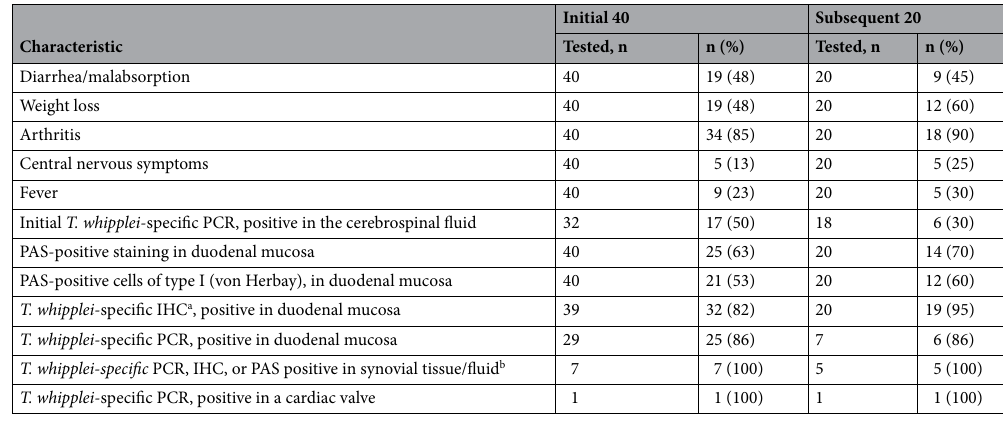
Table 1. Baseline clinical characteristics in the two groups of patients with Whipple’s disease. Significance (Fisher’s exact test): not signisicant for all parameters. a IHC: specific immuno-histochemistry. b Detection of T. whipplei in synovial fluid by PCR and in synovial tissue by PAS staining and